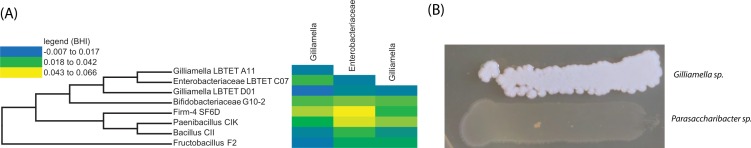
In vitro growth assays using bee specific microbes.Negative interactions inferred by correlations between abundance profile for honey bee specific bacteria are not confirmed by in vitro assays. (A) Phylogeny of bacterial isolates used in a co-culture interaction assay and co-culture assay results (heatmap). Change in optical density from expected values based on growth in isolation plotted as a heat map (yellow = more growth than expected; blue = less growth than expected). No statistically significant growth differences found for growth with Gilliamella compared to growth alone. (B) Growth of Gilliamella on hard agar plates next to Parasaccharibacter, another honey bee associated strain. When grown in broth co-culture, or on hard agar, Gilliamella species do not exhibit antagonistic interactions.